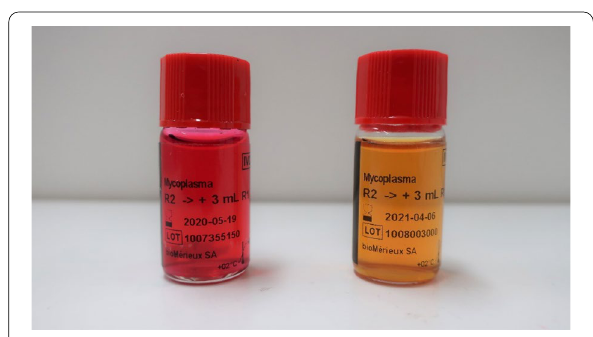
Fig. 2 The broth in which color changed from yellow to red (left) and the control broth